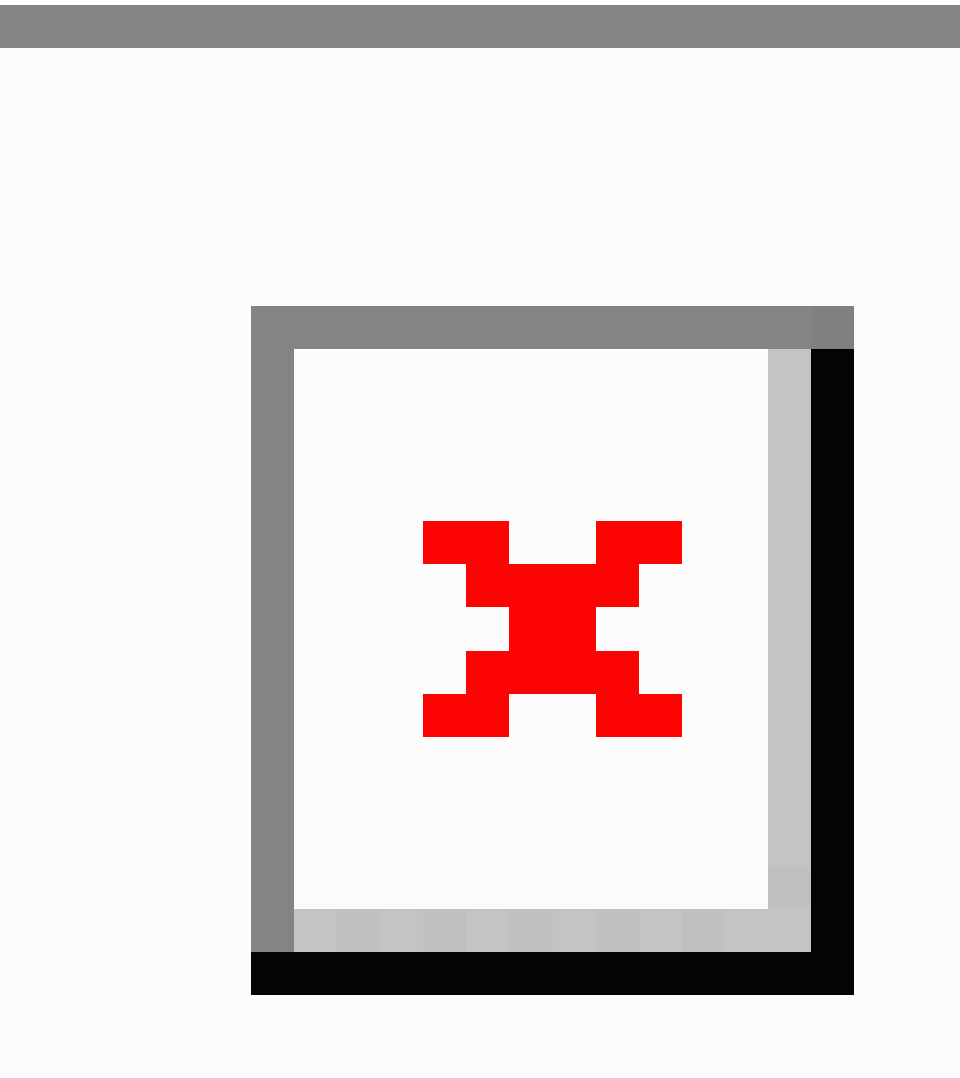
Figure 2. Sensitivity of model results to assigning an arbitrary time spent online to page views that resulted in a time-out (estimate from the zero-inflated Poisson model for the ratio of the mean time spent online comparing individuals who received content in a prescriptive [RX] tone versus a motivational tone